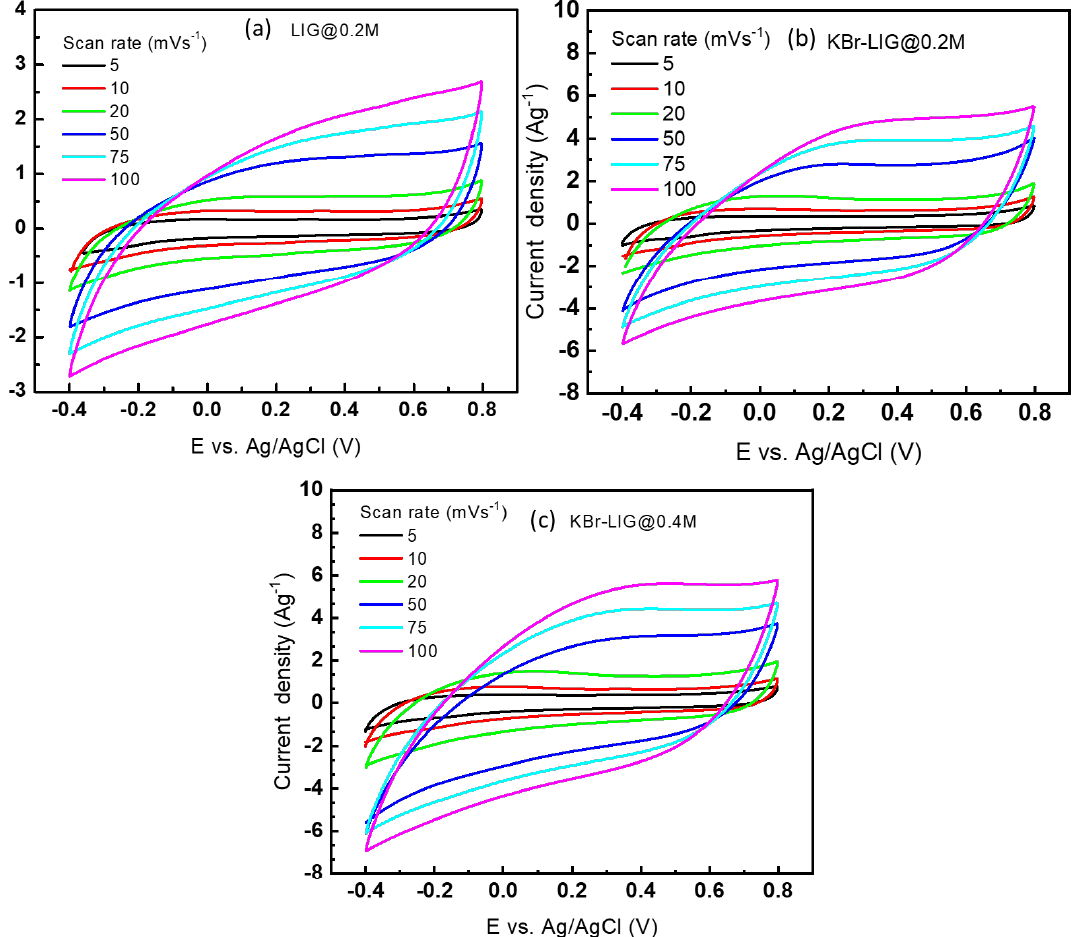
Figure 4. Cyclic voltammetry curves measured at different scan rates of ( a ) LIG@0.2M, ( b ), and ( c ) KBr-LIG at 0.2 and 0.4 M of KBrO 3 electrolyte.